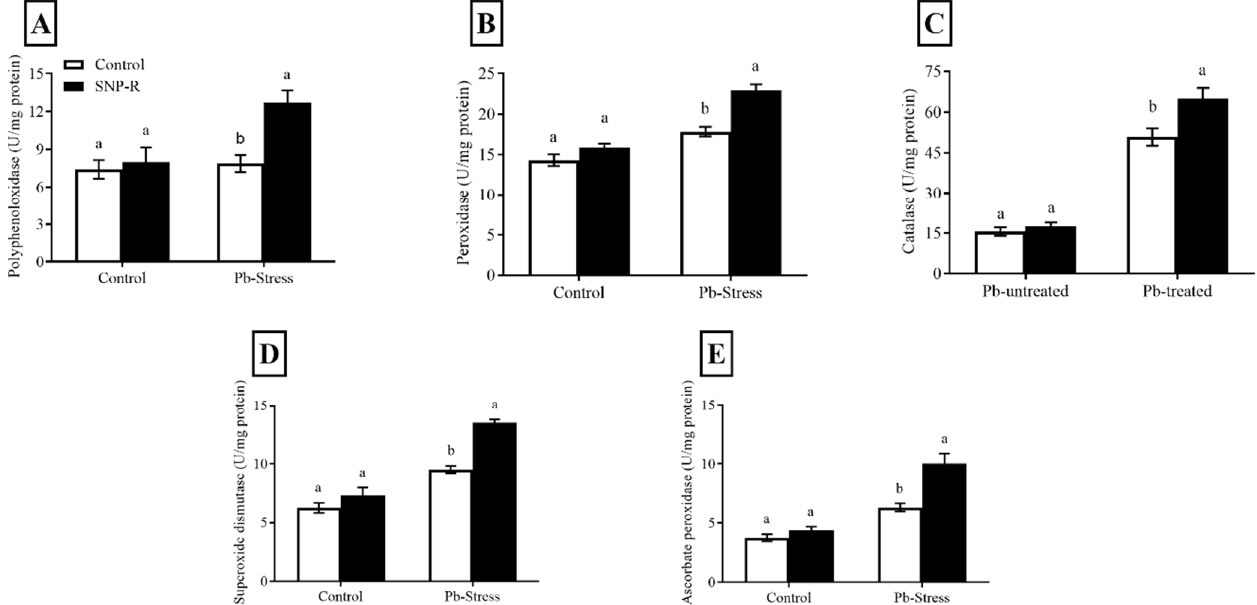
Figure 4. Effect of exogenously applied SNP on rice with or without Pb-induced stress. ( A ) Polyphenol oxidase; ( B ) peroxidase; ( C ) catalase; ( D ) superoxide dismutase; ( E ) ascorbate peroxidase. Each data point indicates the mean ± standard deviation ( n = 3). Bars with different letters indicate significant differences, according to Duncan’s multiple range test. The results are compared to the respective controls (Pb-untreated and Pb-treated plants).